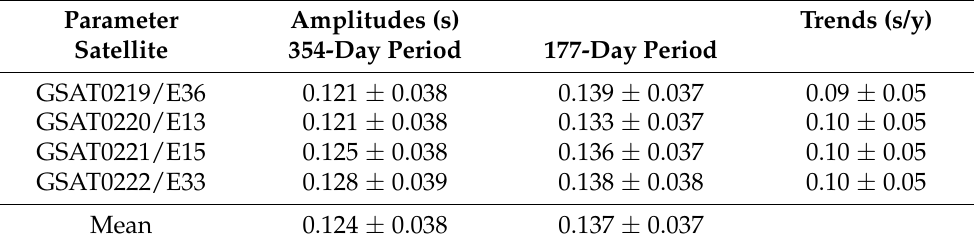
Figure 7. GSAT0220/E13 orbital period time series and the fitted trajectory model consisted of linear trend and two periodic signals (177- and 354-day period). [Unit: seconds]. Table 3. The estimated amplitudes and trends for the orbital period derived from the daily means time